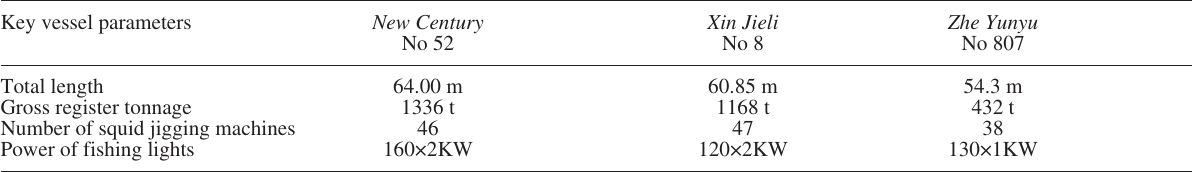
Table 1. – The key parameters of the three squid jigging vessels used in this study. Key vessel parameters